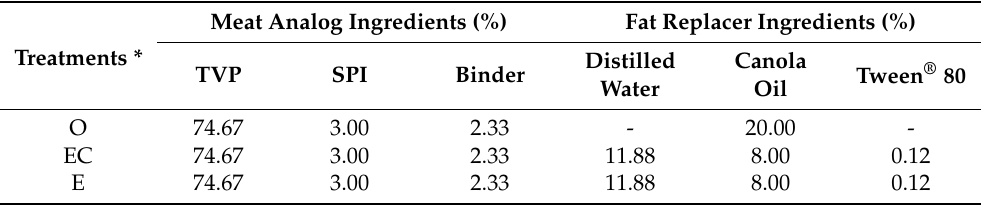
Table 1. Final component of the meat analog and fat